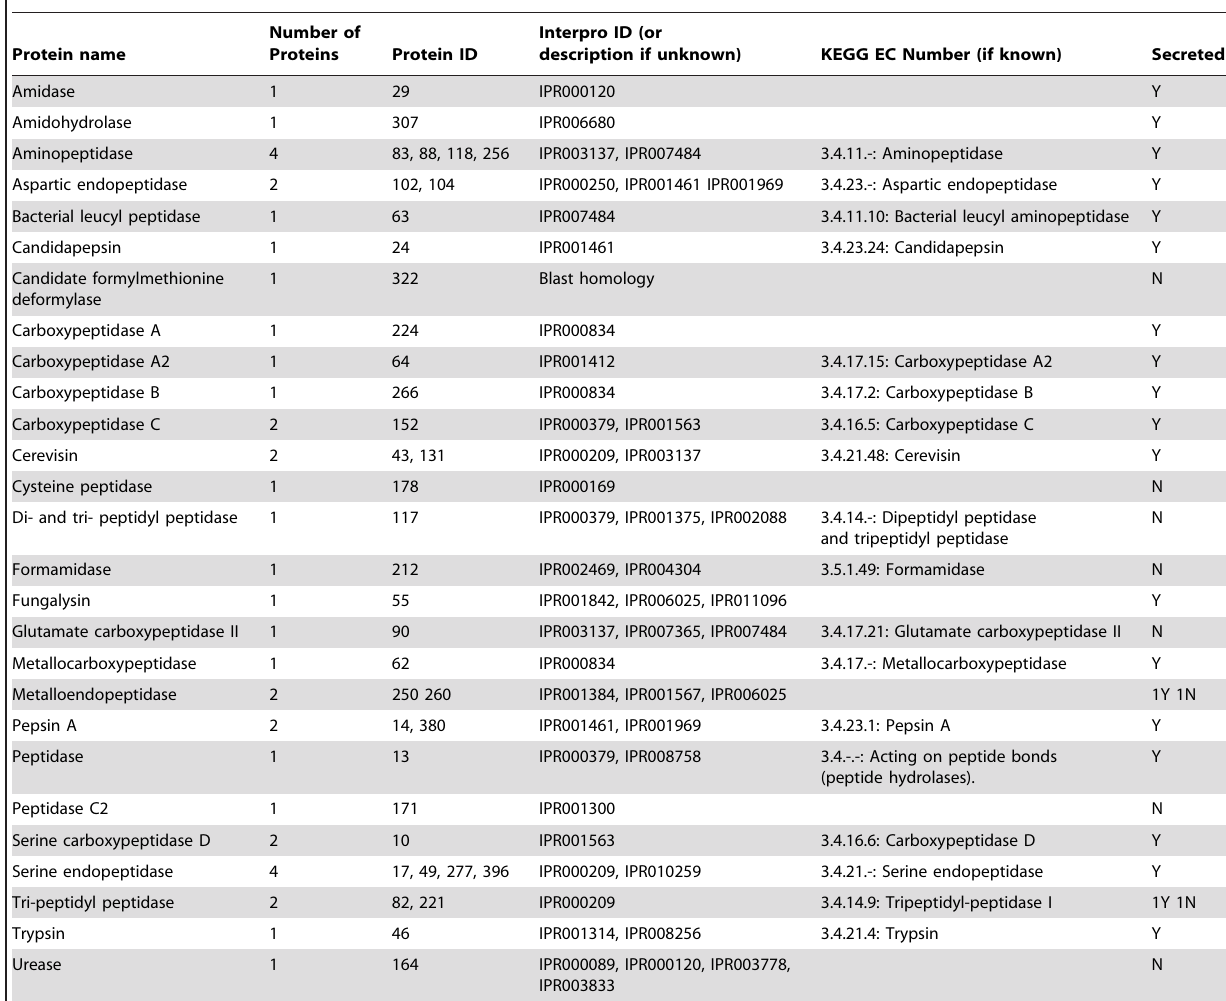
Table 6. Proteinases and nitrogen recycling proteins identified from MudPIT